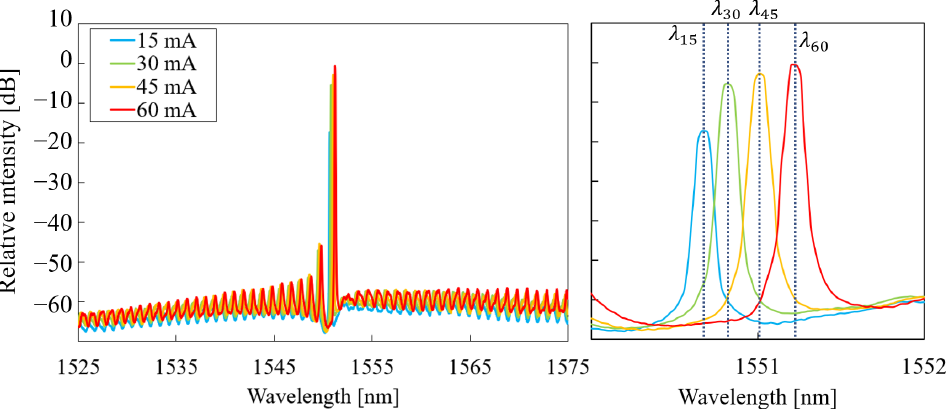
Figure 6. Measured laser spectrum for currents. The detailed view shows the main extracted emission wavelength. The intensity of power spectral density was measured at a resolution of 20